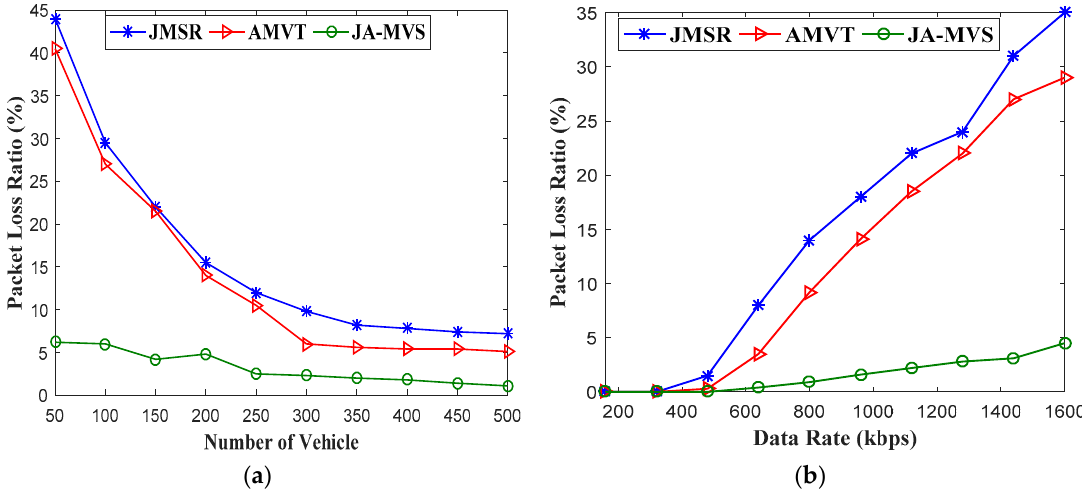
Figure 5. Packet Loss Ratio based on ( a ) varied vehicle densities and ( b ) data rates.